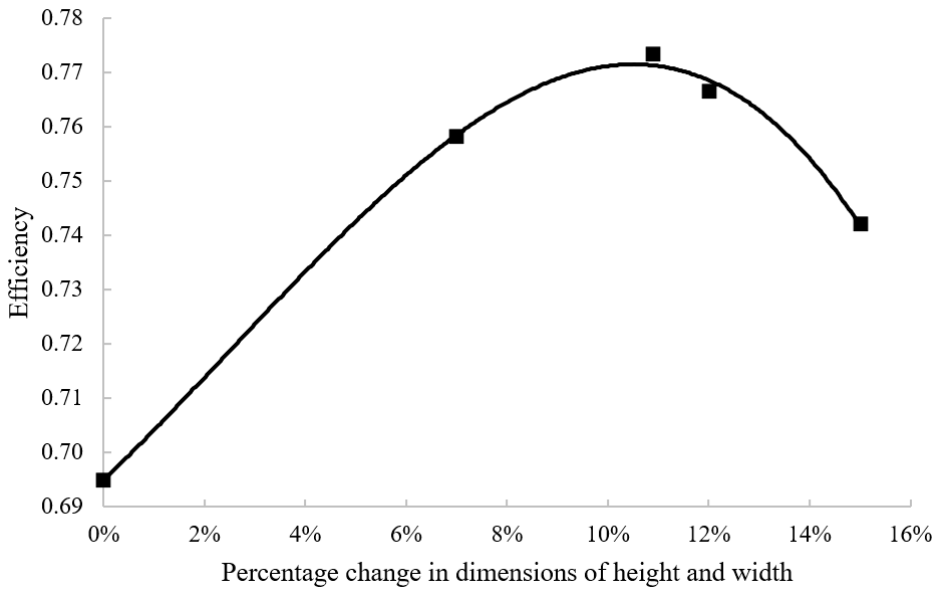
Figure 15. Efficiency against the percentage reduction in height and increase in depth relative to the original blade dimensions.